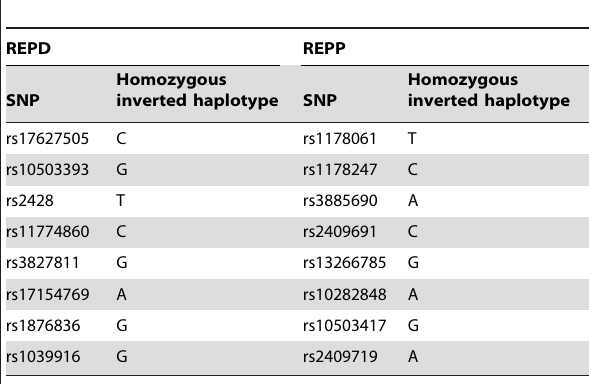
Table 1. FISH analysis of 8p23.1 inversion in Spanish control individuals. Table 2. Tracts of homozygosity in 8p23.1 region extracted from the whole genome scan data performed in homozygous inverted